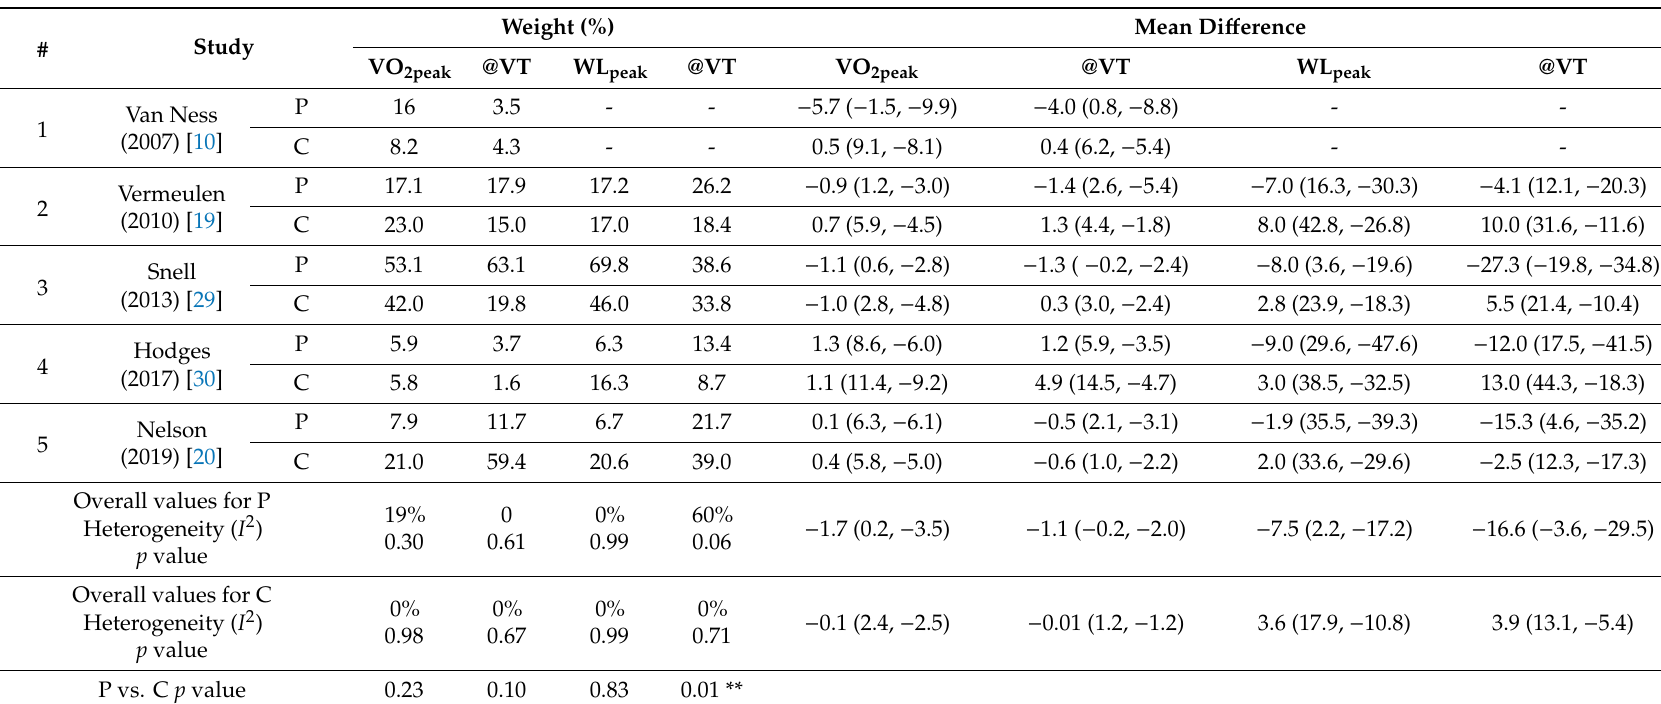
Table 3. Meta-analysis of two-day CPET (test 2–test 1) for the comparisons between the ME / CFS patients and